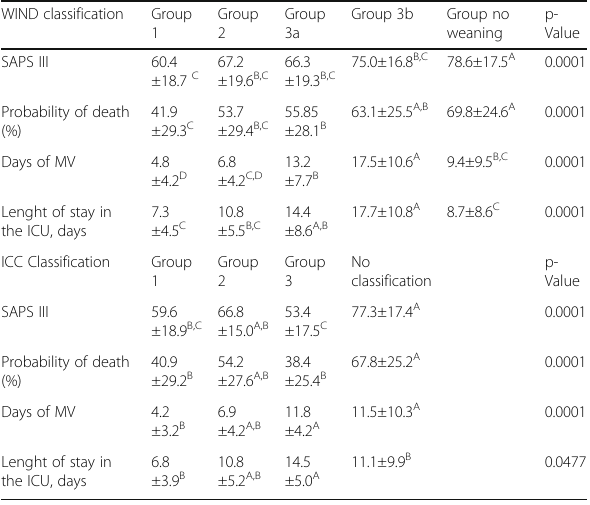
Table 3 (abstract 0136). Multiple comparisons between groups. Equal letters on the top right side of the numbers express no differences between